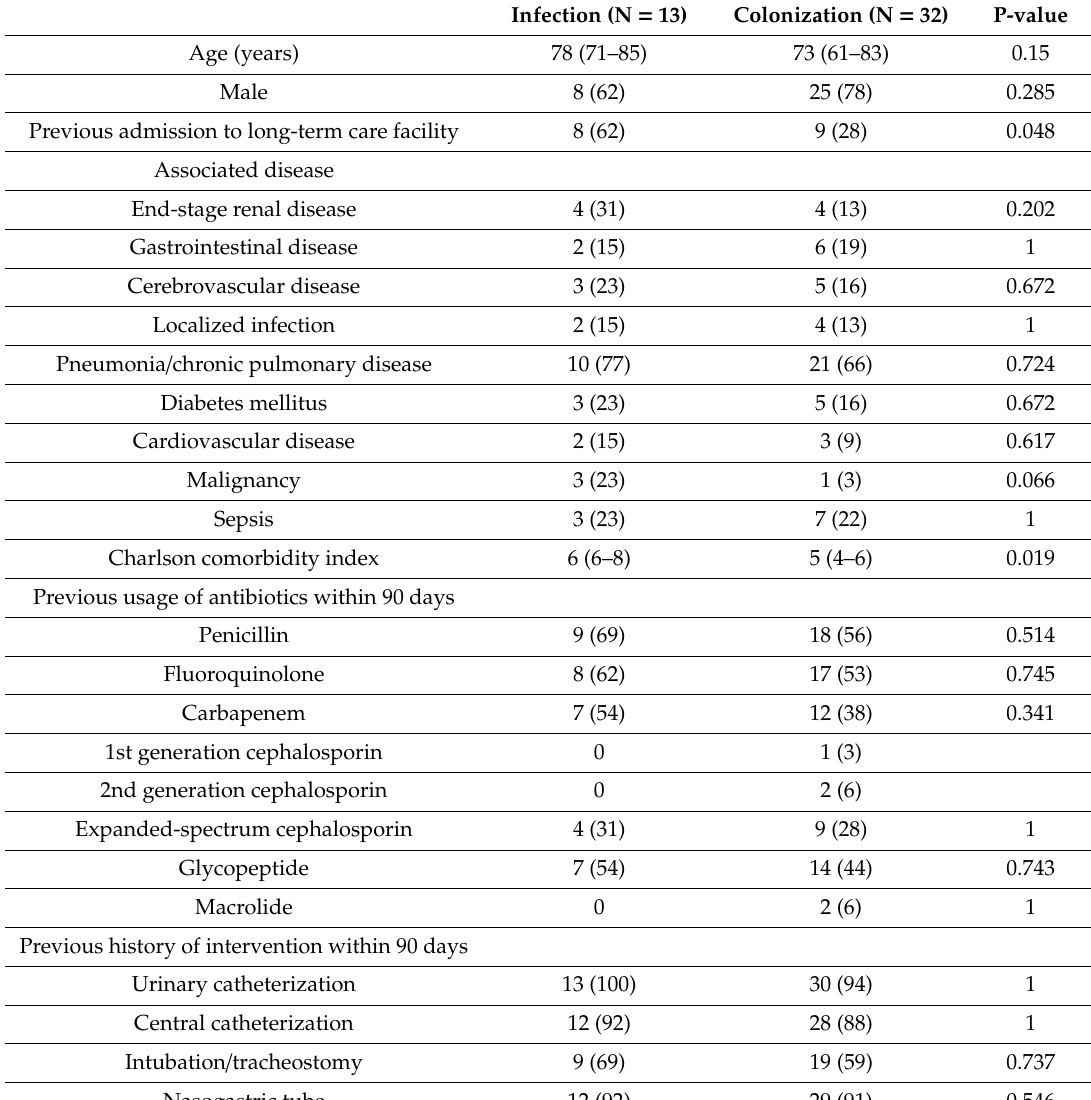
Table 1. Baseline characteristics of patients infected or colonized with carbapenemase-producing Enterobacterales in medical intensive care